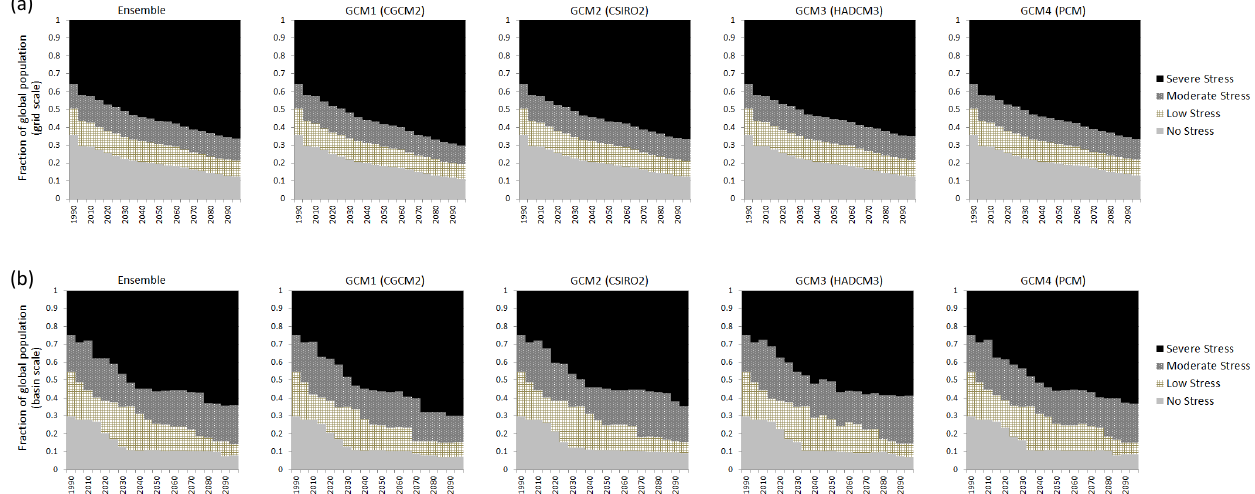
Figure 15. Distributions of global populations facing each of the four levels of water scarcity conditions: severe stress (WSI ≥ 0.4), moderate stress (0.2 ≤ WSI < 0.4), low stress (0.1 ≤ WSI < 0.2), and no stress (WSI < 0.1); WSI values are computed at the grid (top panel) and basin (bottom panel) scales and then the shares of populations are aggregated to the global scale.